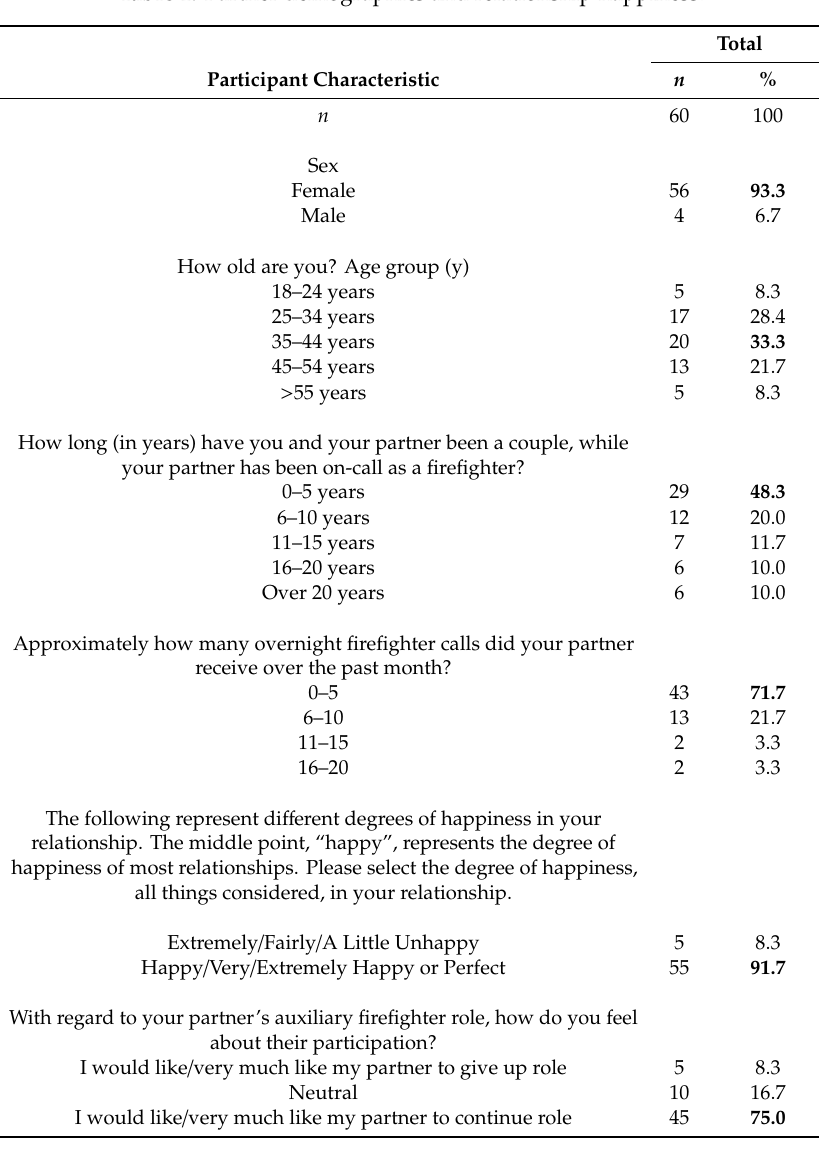
Table 1. Partner demographics and relationship happiness.